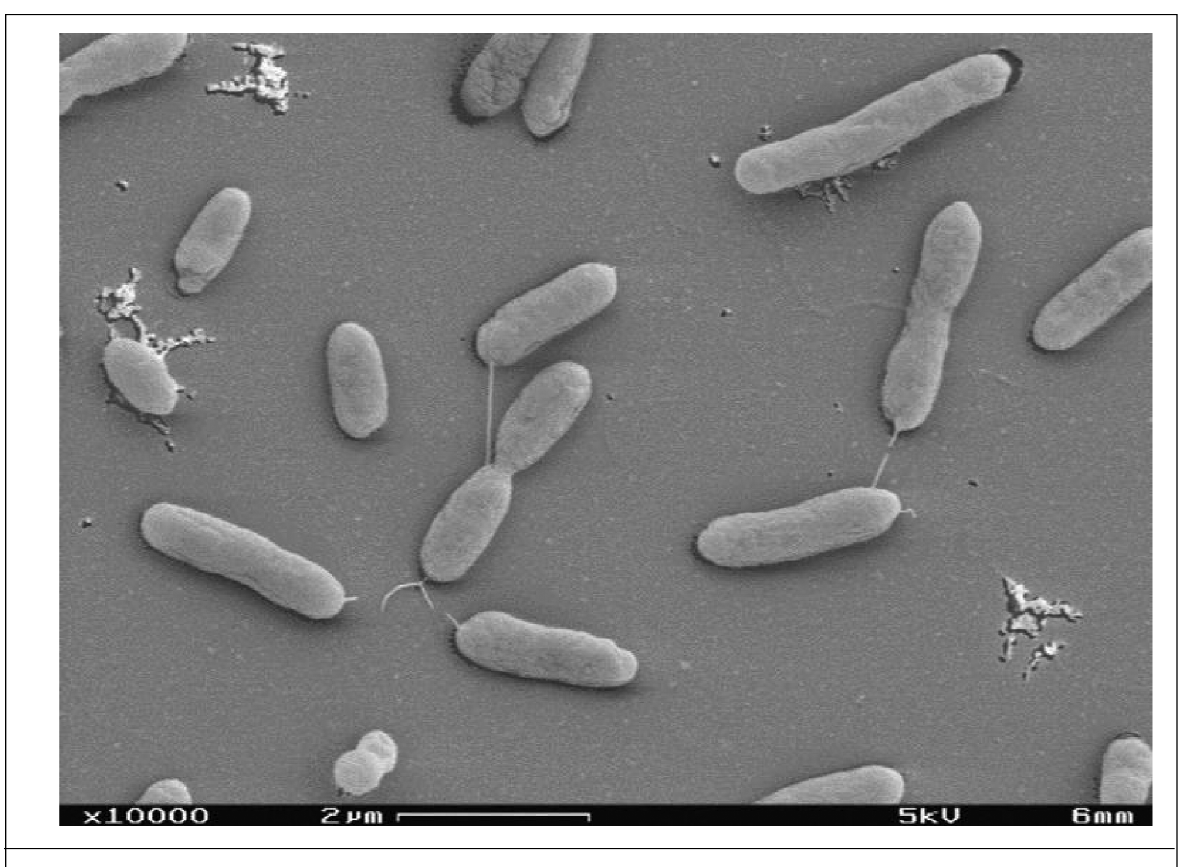
Figure 1: Electromicrographs of the cells of strain E48 T at 10,000